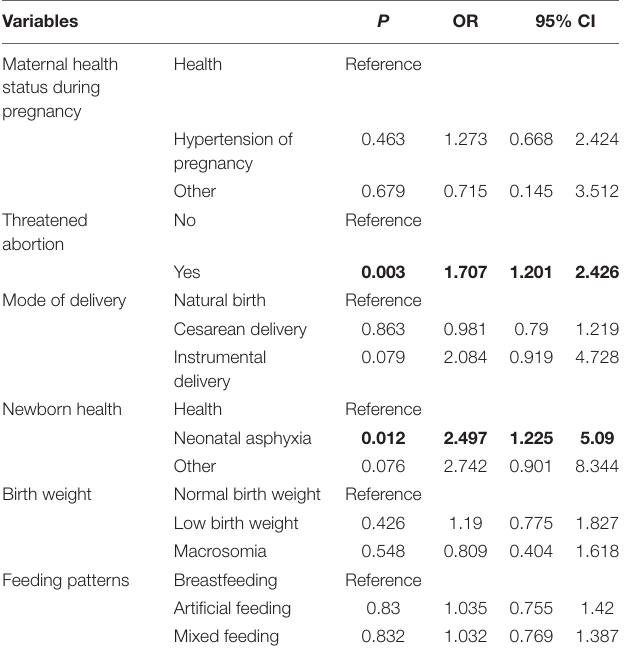
TABLE 3 | Results of multivariate analysis (logistic regression analysis) showing relationship between ADHD and maternal events occurring during pregnancy and perinatal period in the second model ( n =